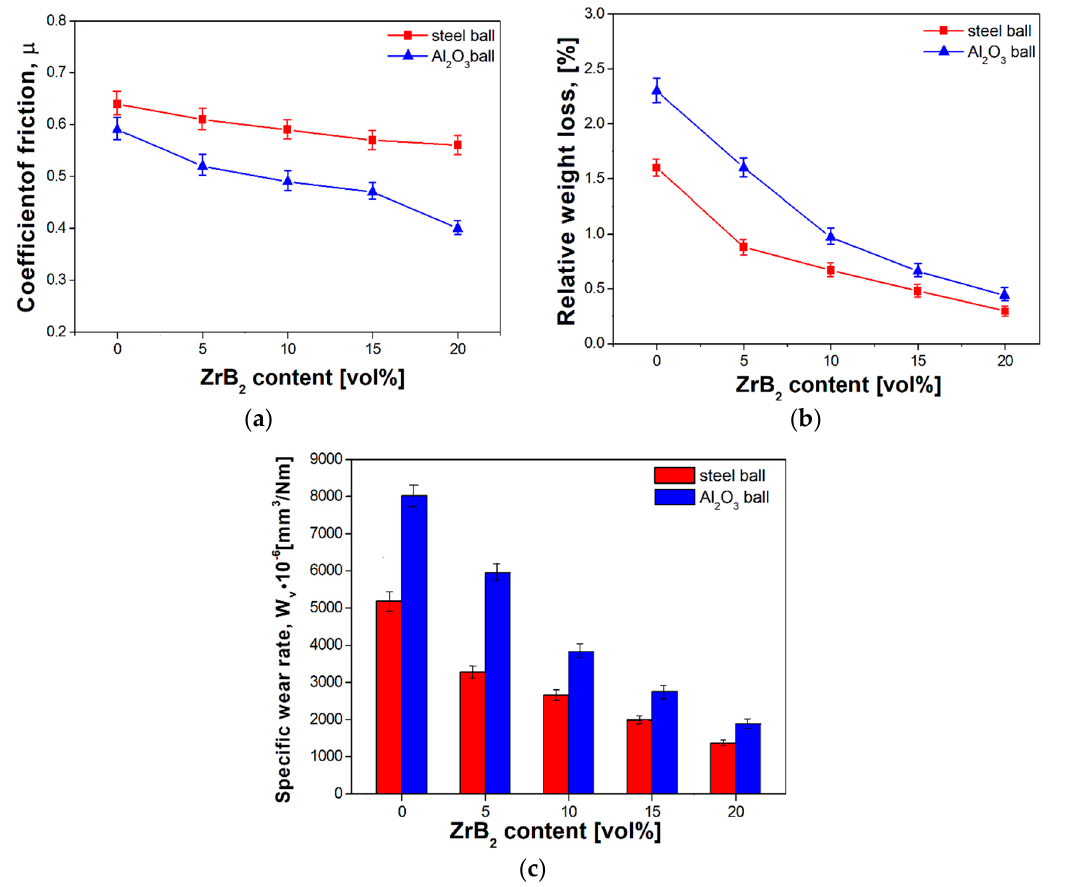
Figure 12. Effect of ZrB 2 content on ( a ) coefficient of friction, ( b ) relative weight and ( c ) specific wear Figure 12. E ff ect of ZrB 2 content on ( a ) coe ffi cient of friction, ( b ) relative weight and ( c ) specific wear rate of sintered composites. rate of sintered